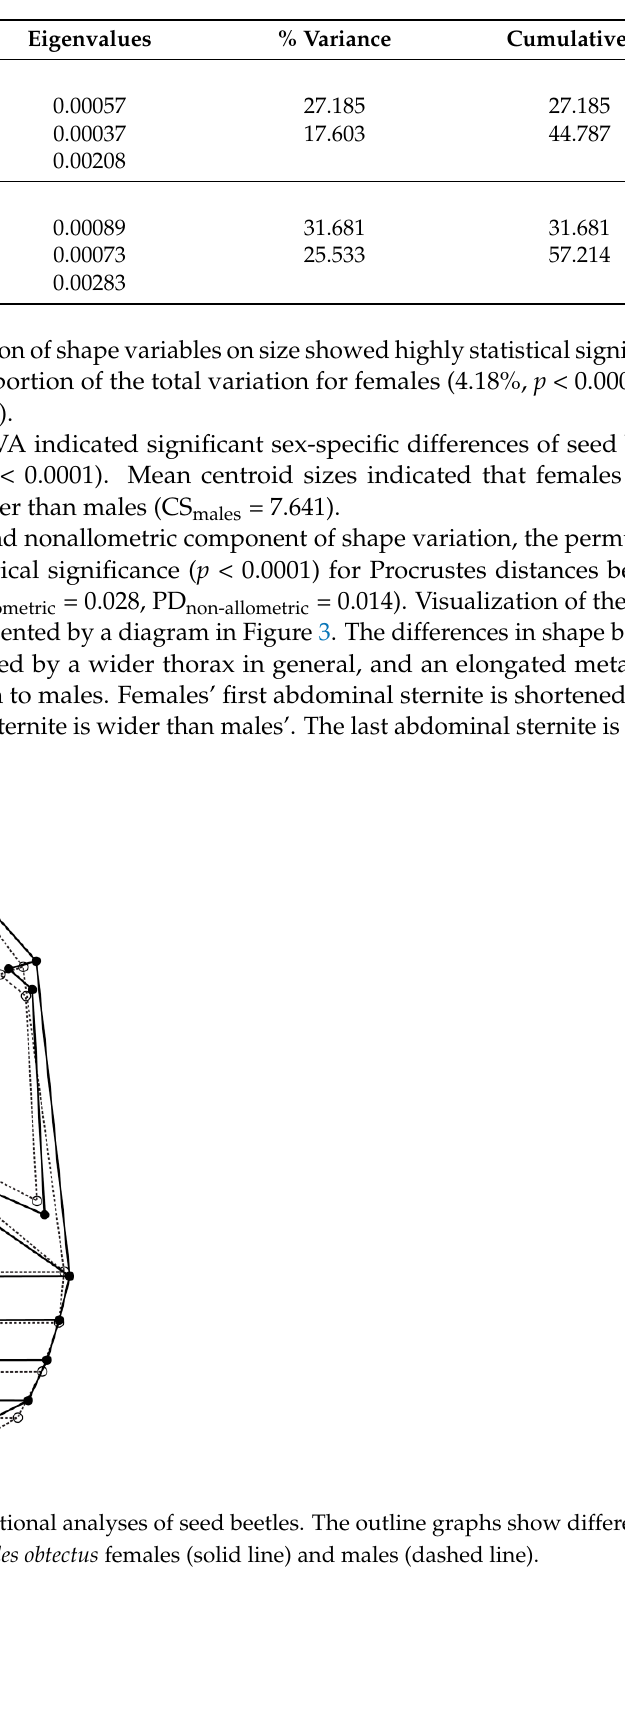
Table 3. Procrustes ANOVA of shape in Acanthoscelides obtectus females and males with effects of individual (interindividual variation) and measurement error. SS—sum of squares, MS—mean of the sum of squares, df—degree of freedom, F—value of F test, p —level of statistical significance. SS